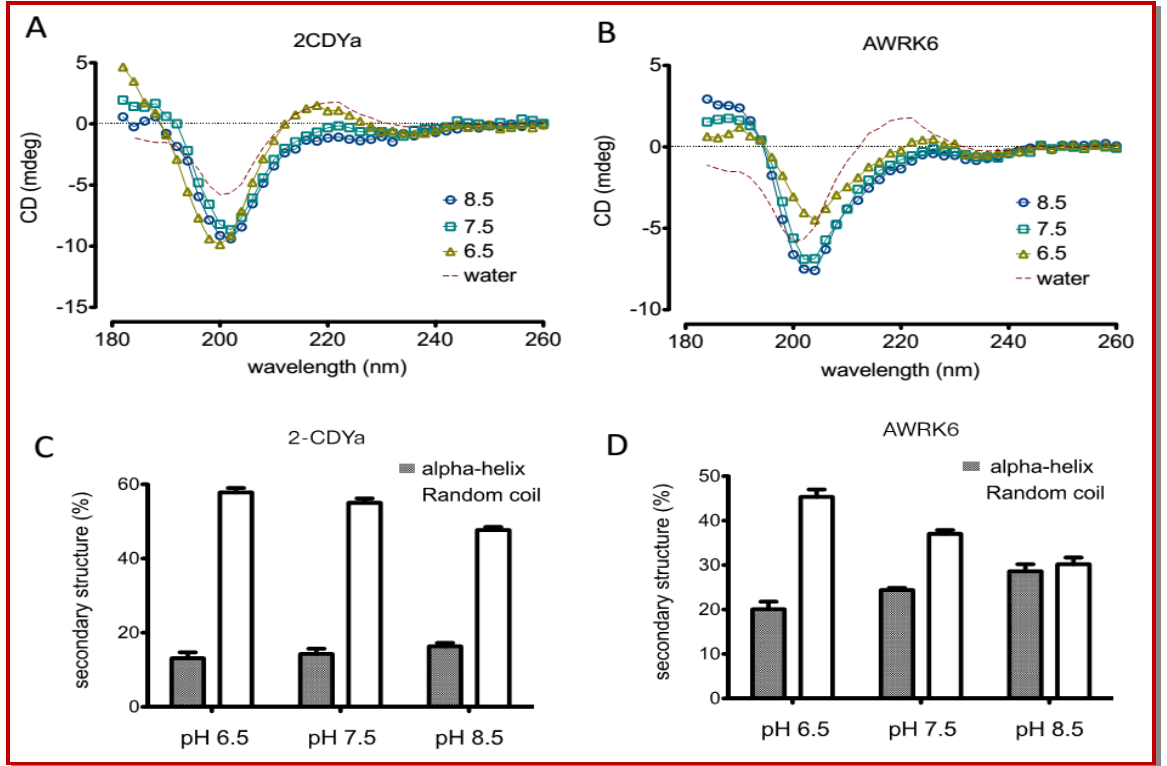
Figure 4: CD spectroscopy of Dy2 and AWRK6 CD spectra of Dy2 (A) and AWRK6 (B) determined at a concentration of 500 μ g/mL in 10 mM sodium phosphate buffer having different pH. As a control, potassium phosphate buffer was used as a function of the pH 6.5, 7.5 and 8.5 and in dWater (dashed line). All solutions were examined in the presence of 30 mM SDS to mimic the interaction of peptides with bacterial cell membrane. Percentage of estimated secondary structure of Dy2 (C) and AWRK6 (D). Data are the means ± SEMs from experiment repeated 5